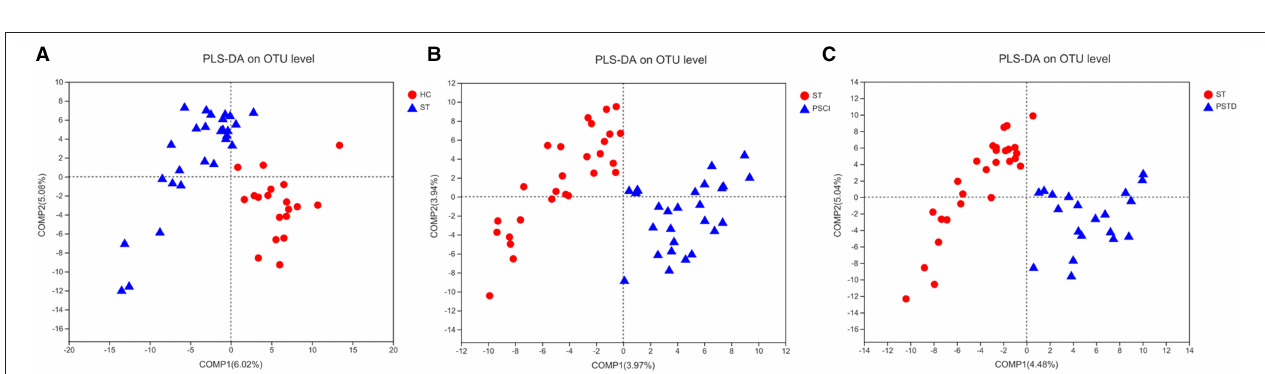
FIGURE 7 | Distribution of the predominant bacteria at the species level of different groups. (A) ST vs. HC, (B) PSCI vs. ST, (C) PSTD vs. ST. The predominant taxa (>1% relative abundance) in each level are shown.